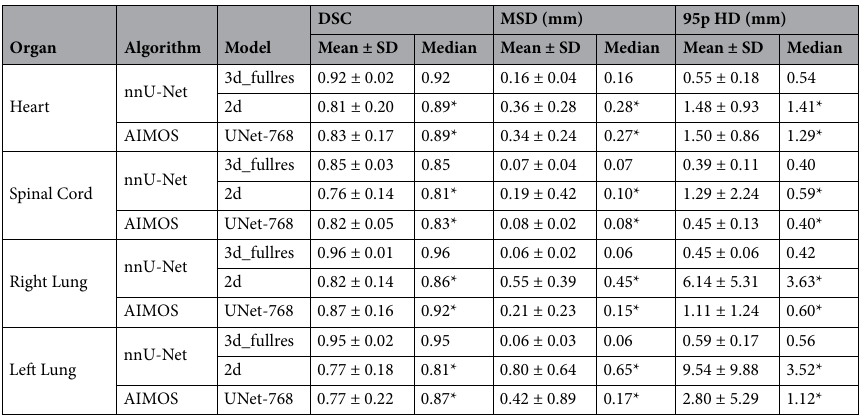
Table 2. Comparison of the the segmentation accuracy between different models in terms of the DSC, MSD and 95p HD (mean ± SD and median) for test set 2 annotated by observer 1. The asterisk (*) indicates a